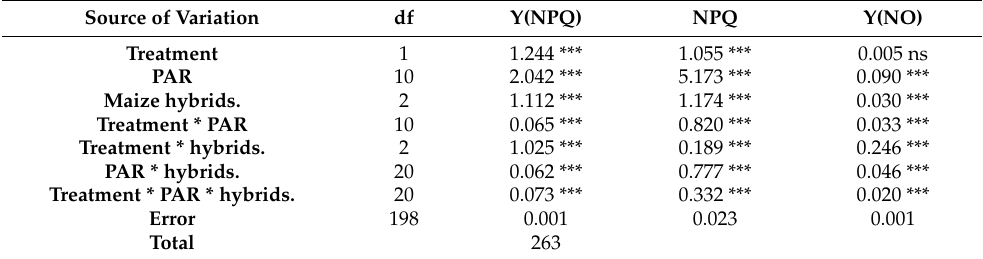
Table 2. Mean square values from analysis of variance (ANOVA) for Y(NPQ), NPQ and Y(NO) of three maize ( Zea mays L.) hybrids differing in drought tolerance when two-week-old plants were subjected to three cycles of drought stress.